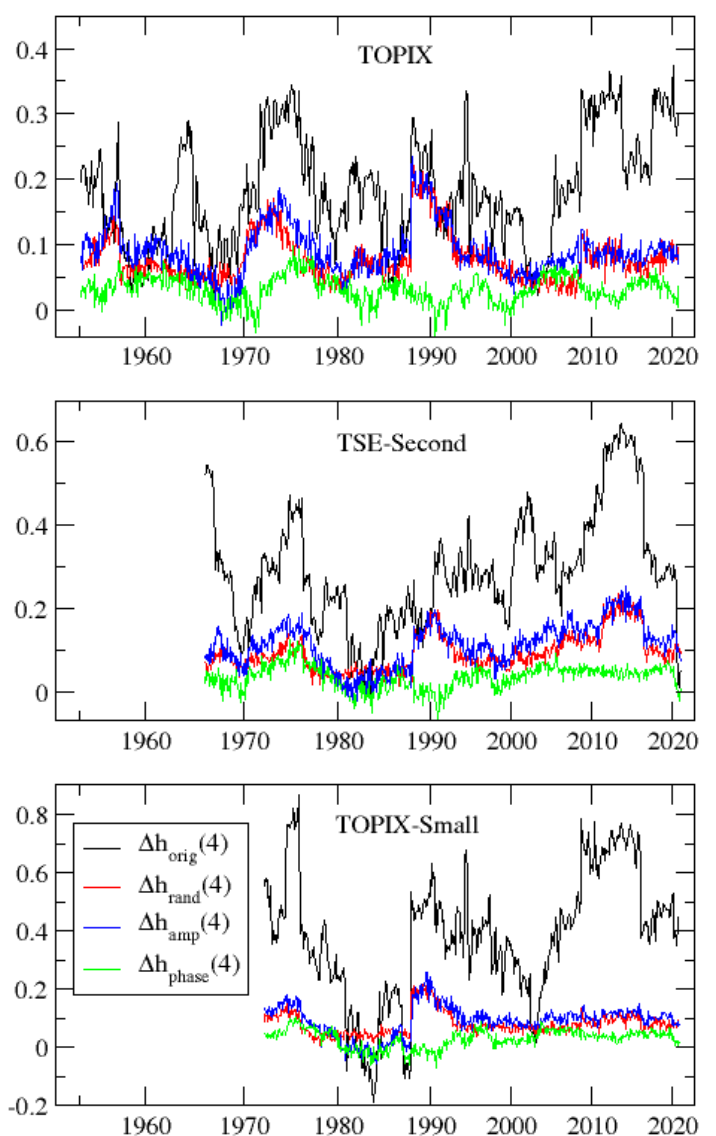
Figure 6. Time evolution of ∆ h orig ( 4 ) (black) and ∆ h rand ( 4 ) (red), ∆ h amp ( 4 ) (blue), and ∆ h phase ( 4 )